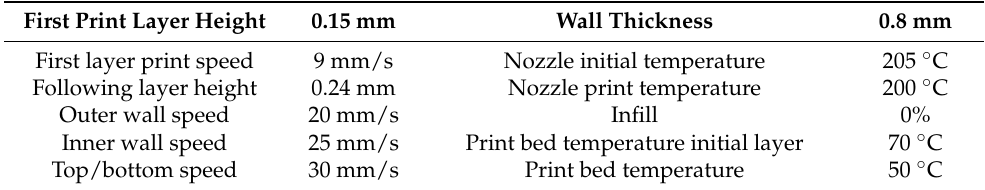
Table 1. 3D fused deposition modelling (FDM) printing parameters used in microfluidic channel mold